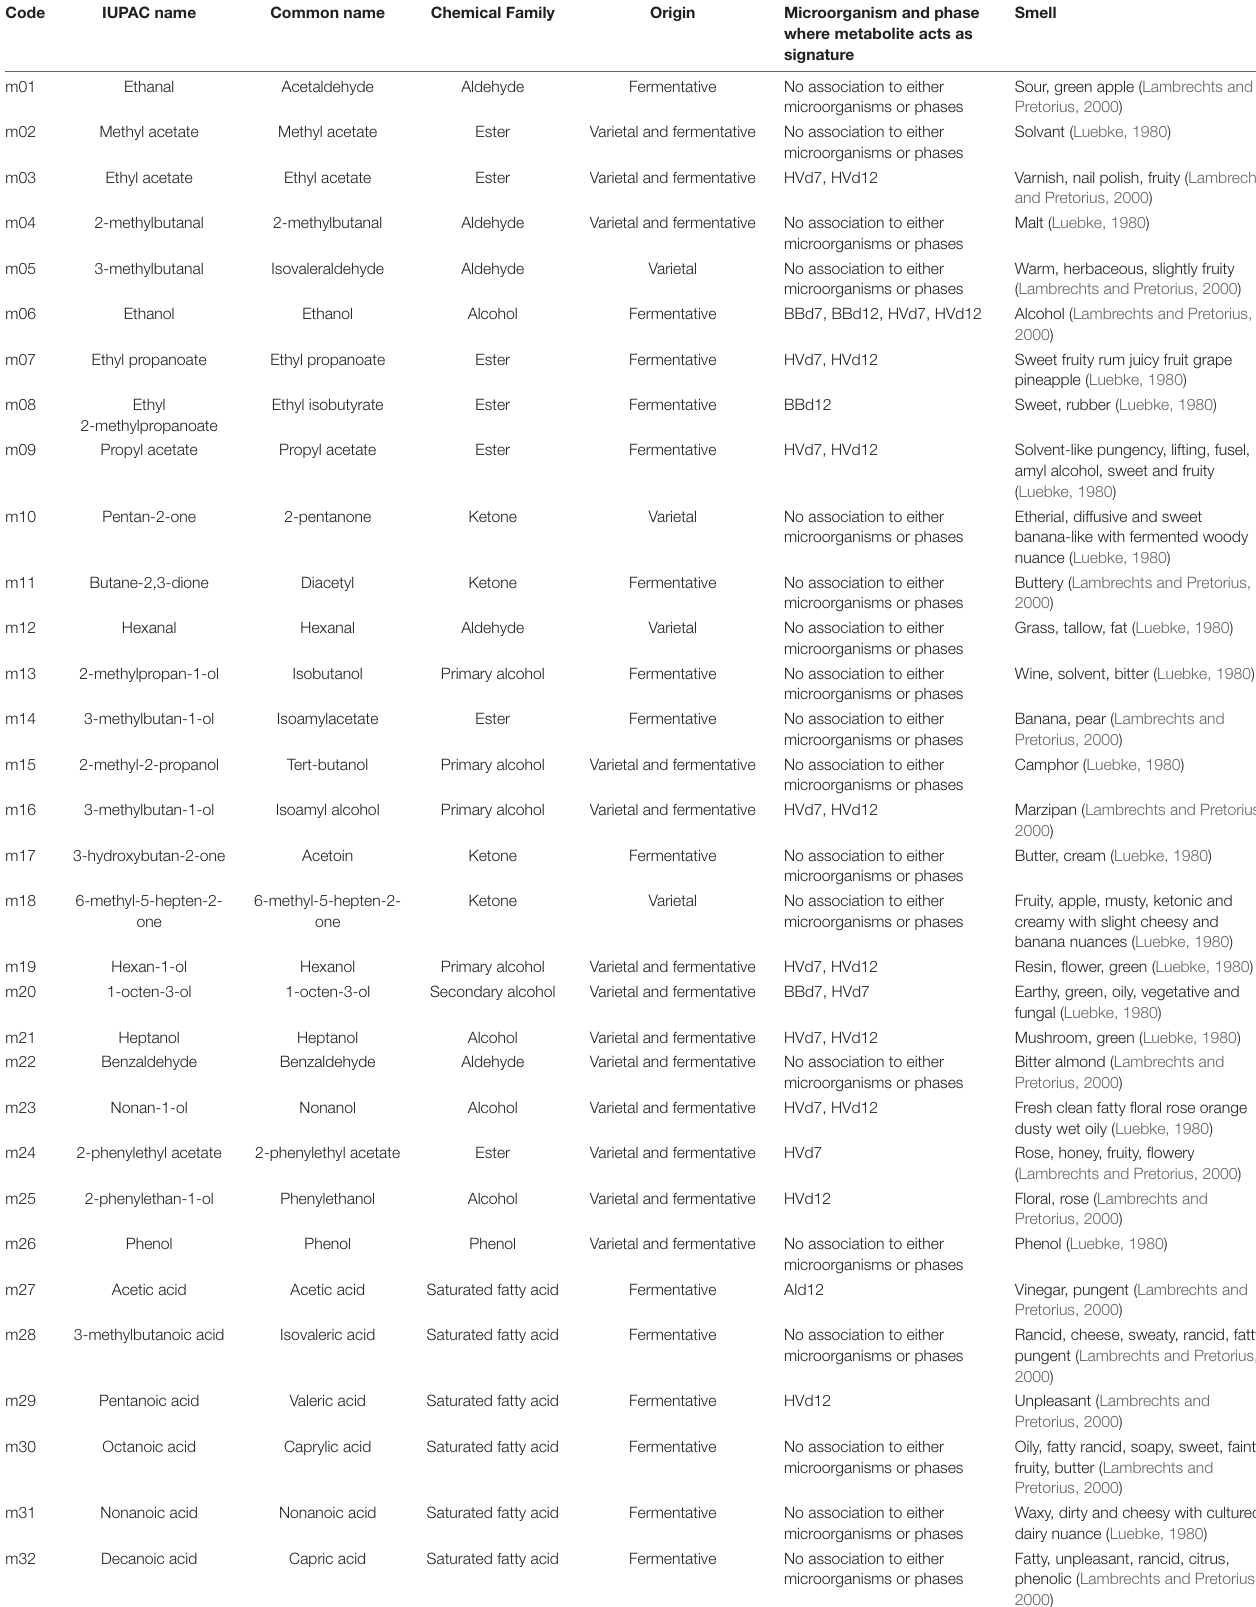
TABLE 2 | Detected and quantified volatile metabolites with chemical, sensory and origin features (Luebke, 1980; Lambrechts and Pretorius,